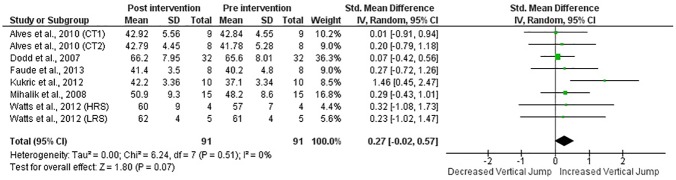
Standardized mean difference (SMD) between post and pre-intervention VJ height in CT-trained subjects.Squares represent the SMDa for each trial. Diamonds represent the pooled SMD across trials.